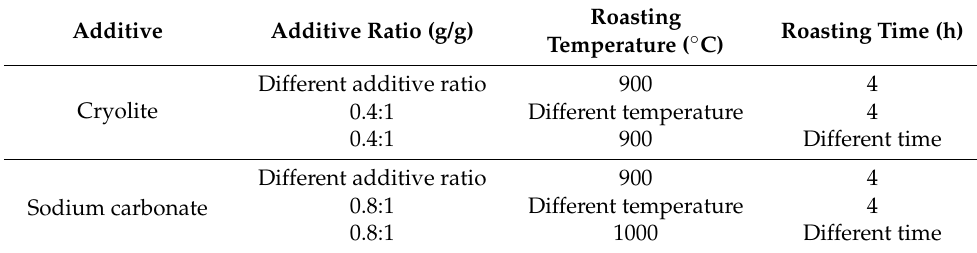
Table 1. Relevant experimental parameters.